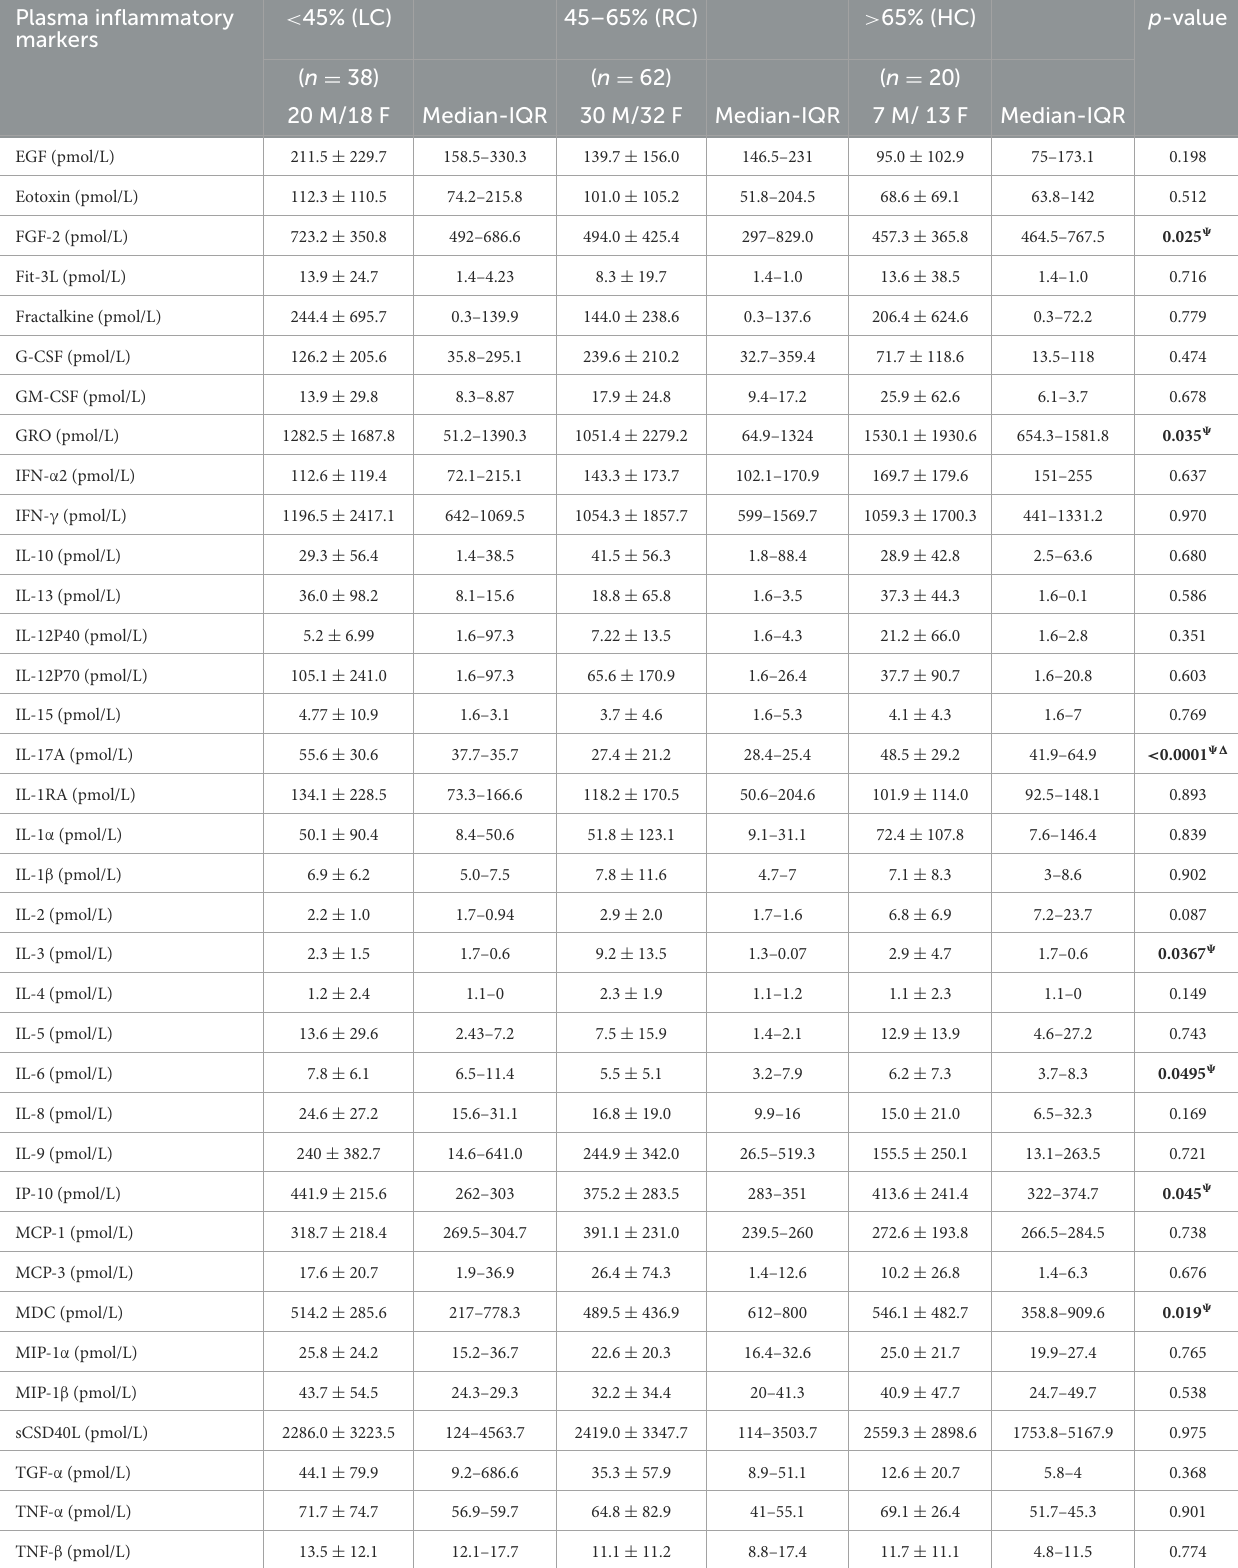
TABLE 4 Group-based comparison of plasma inflammatory markers. Plasma inflammatory